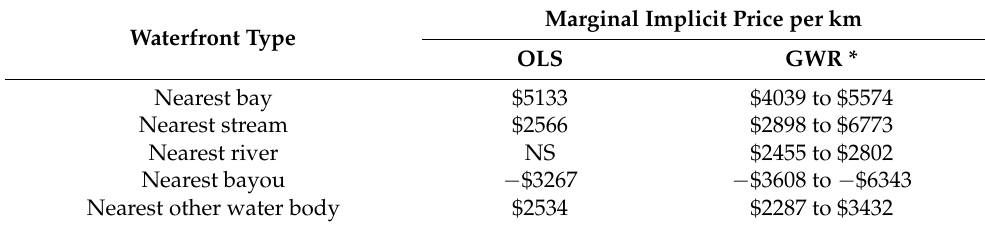
Table 3. Estimated marginal implicit prices per 1 km decrease in distance to waterfront ecosystem